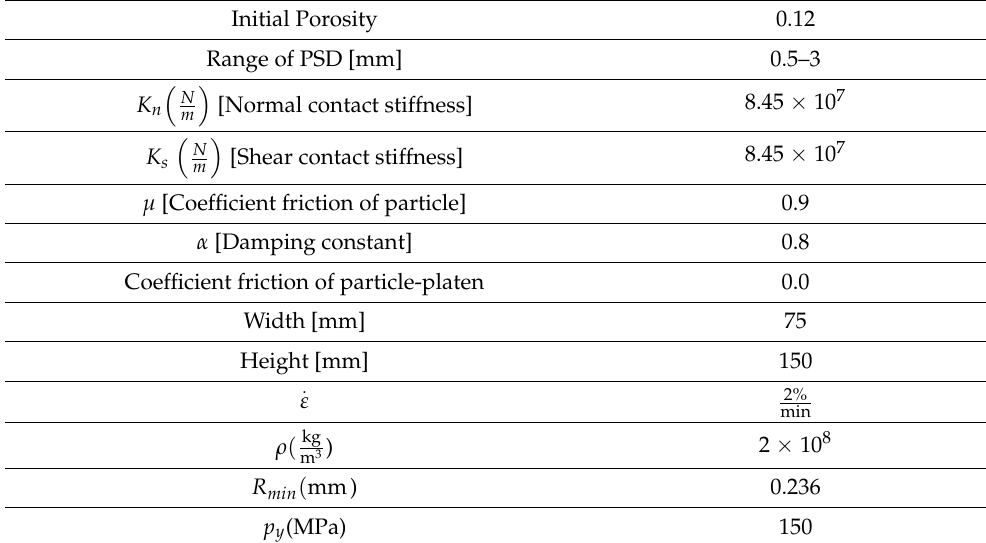
Figure 5. The biaxial sample with rigid top and bottom platens and deformable vertical bounda- ries.